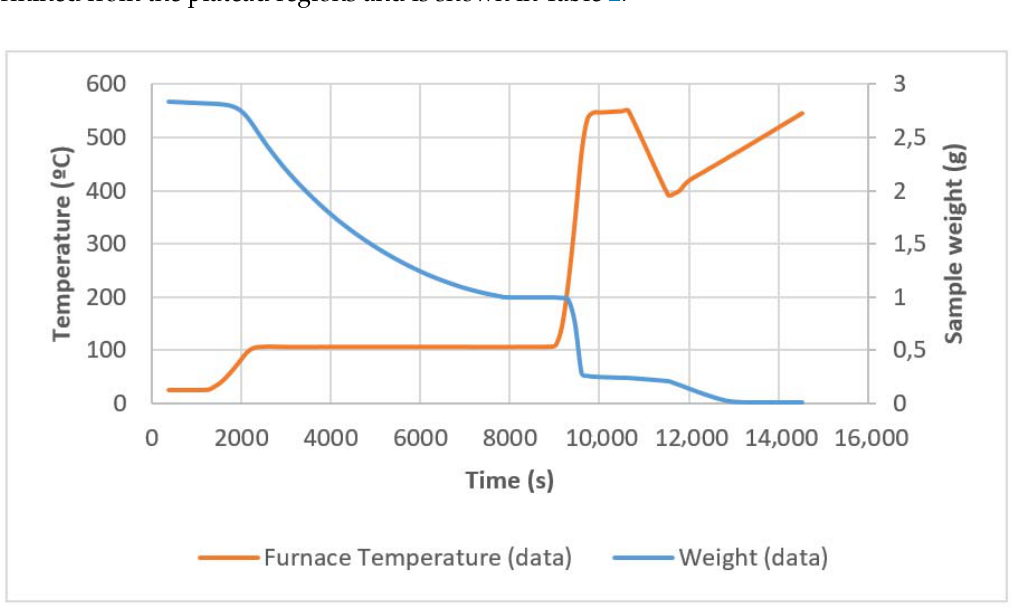
Figure 2. Thermogravimetric analyzer (TGA) weight loss curves for pine dust for a sample of 2.80 g.